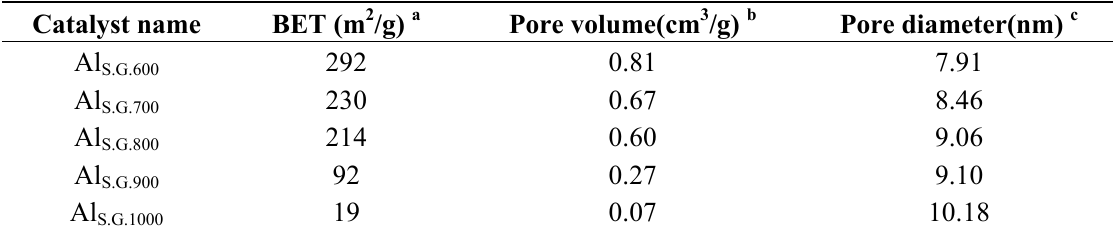
Table 1. Physical properties of sol gel made alumina supports at different calcination